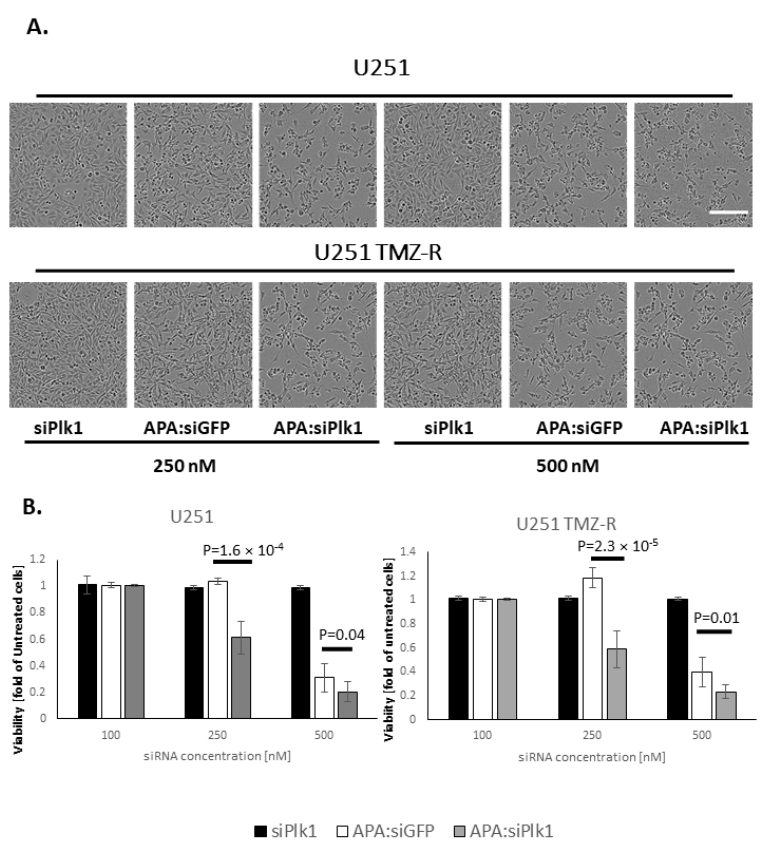
Figure 3. APA:siPlk1 treatment reduced the viability of U251 and U251 TMZ-R cells. ( A ) Representative phase-contrast images of the cells following 20 h of treatment. ( B ) Bar graph of cells viability following 20 h of treatment based on red-channel images (scale = 20 µm).